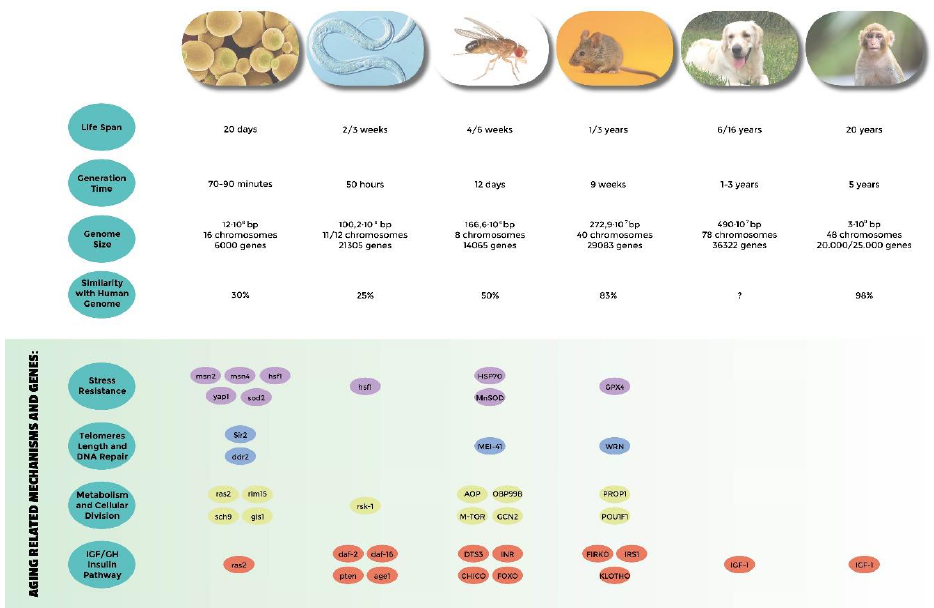
Figure 1. Comparative analysis of the most used model systems in aging research. Genome informations are from NCBI.